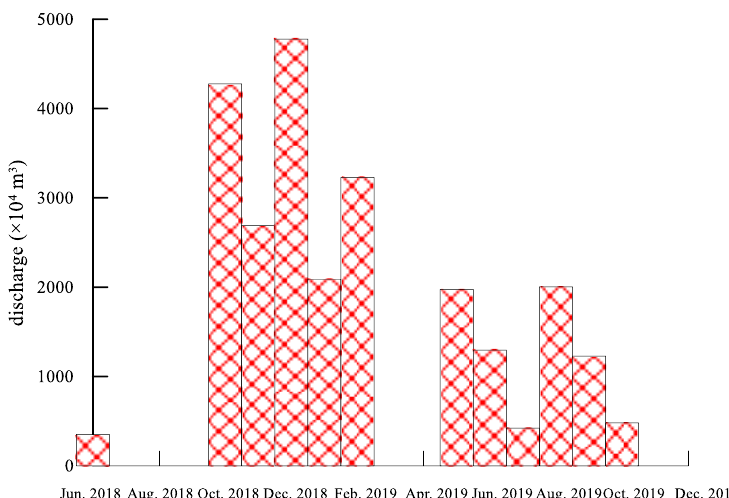
Figure 2. Hydrogeological profile of Section A-A (cid:48) . Figure 2. hydrogeological profile of Section A- A′.